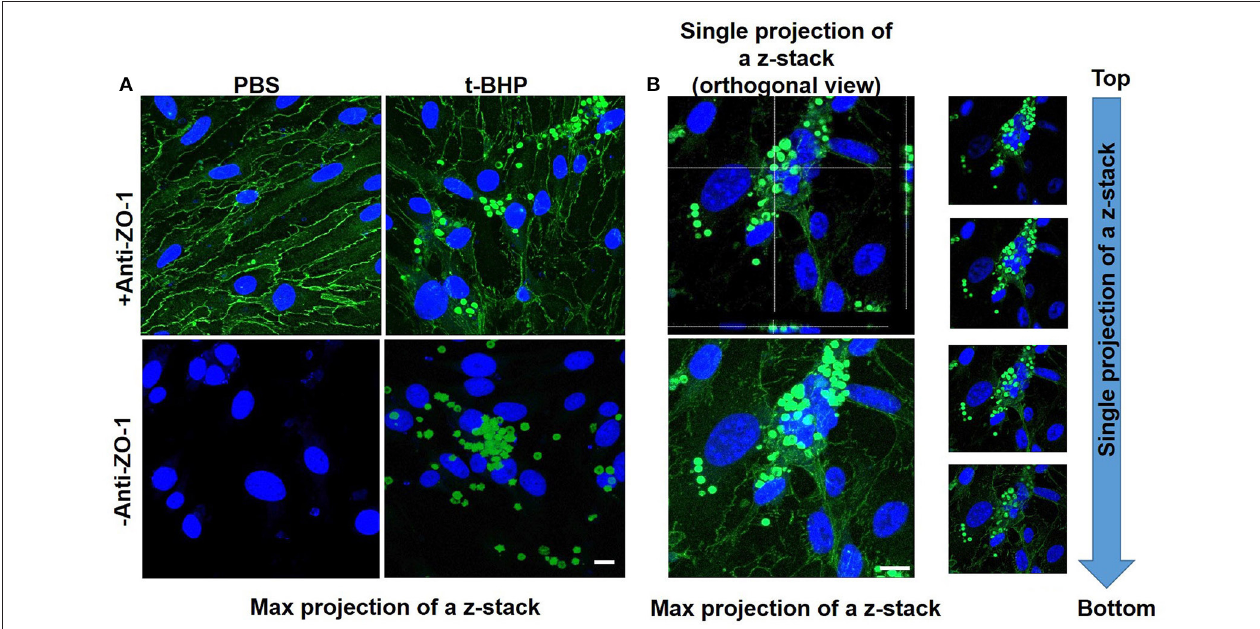
FIGURE 3 | Confocal microscopy of bEND3 cells and RBC to confirm erythrophagocytosis. Maximum projection of z-stack shows adhesion of t-BHP-treated RBC to bEND3 cells and no adhesion of PBS-treated RBC (Blue = DRAQ5 stain for the endothelial nucleus, green = tight junction ZO-1 protein and autofluorescence of RBC) (A) . Orthogonal view of a single projection, maximum projection of a z-stack and individual images of a z-stack moving from top to bottom of a cover glass confirm the internalization of t-BHP-treated RBC by bEND3 cells (B) . Scale bar = 10 µ